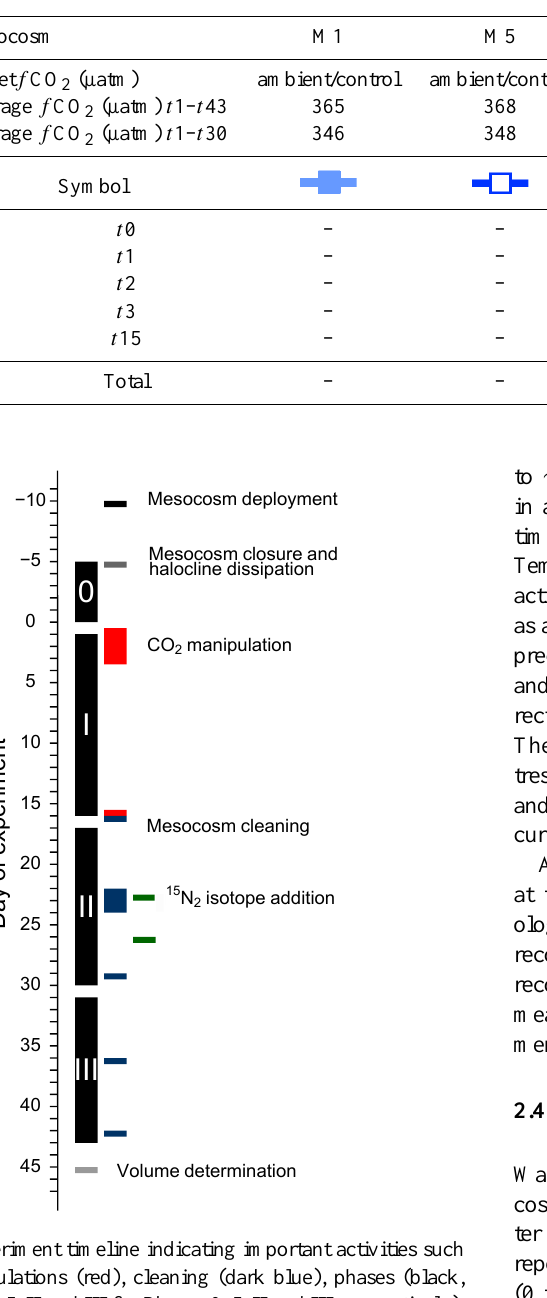
labelled with 0, I, II and III for Phases 0, I, II and III, respectively),